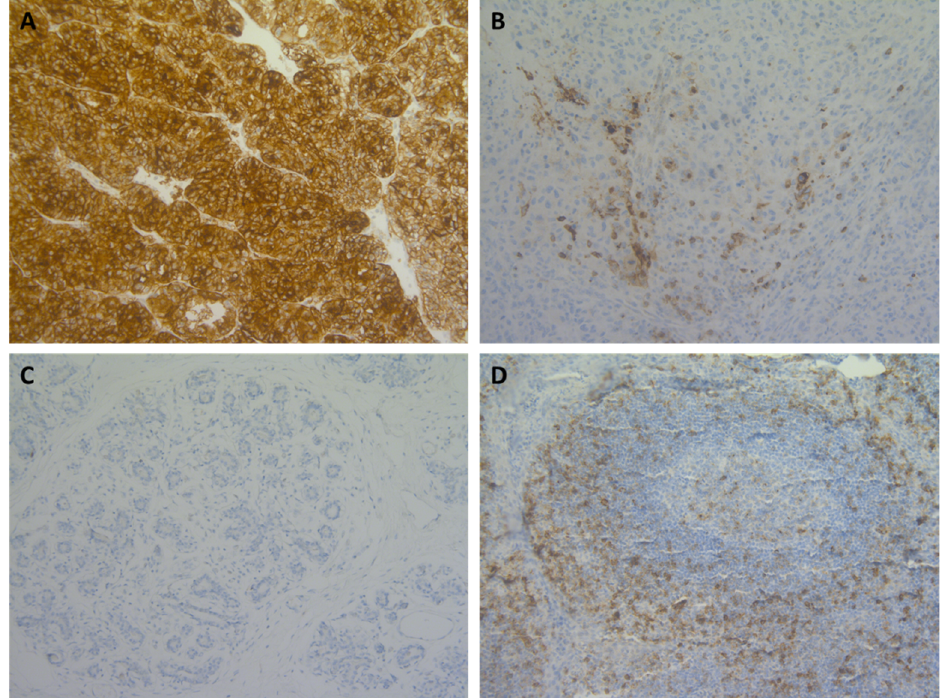
Figure 2. Micrographs of CD70 immunohistochemical stainings across various solid tumour types showing range of staining percentages. ( A ) >50% CD70 staining on tumour cells in renal cell carcinoma; ( B ) 10–50% staining in melanoma; ( C ) <10% staining in breast cancer; and, ( D ) CD70 staining in control tissue (tonsil). Magnitude 200×.